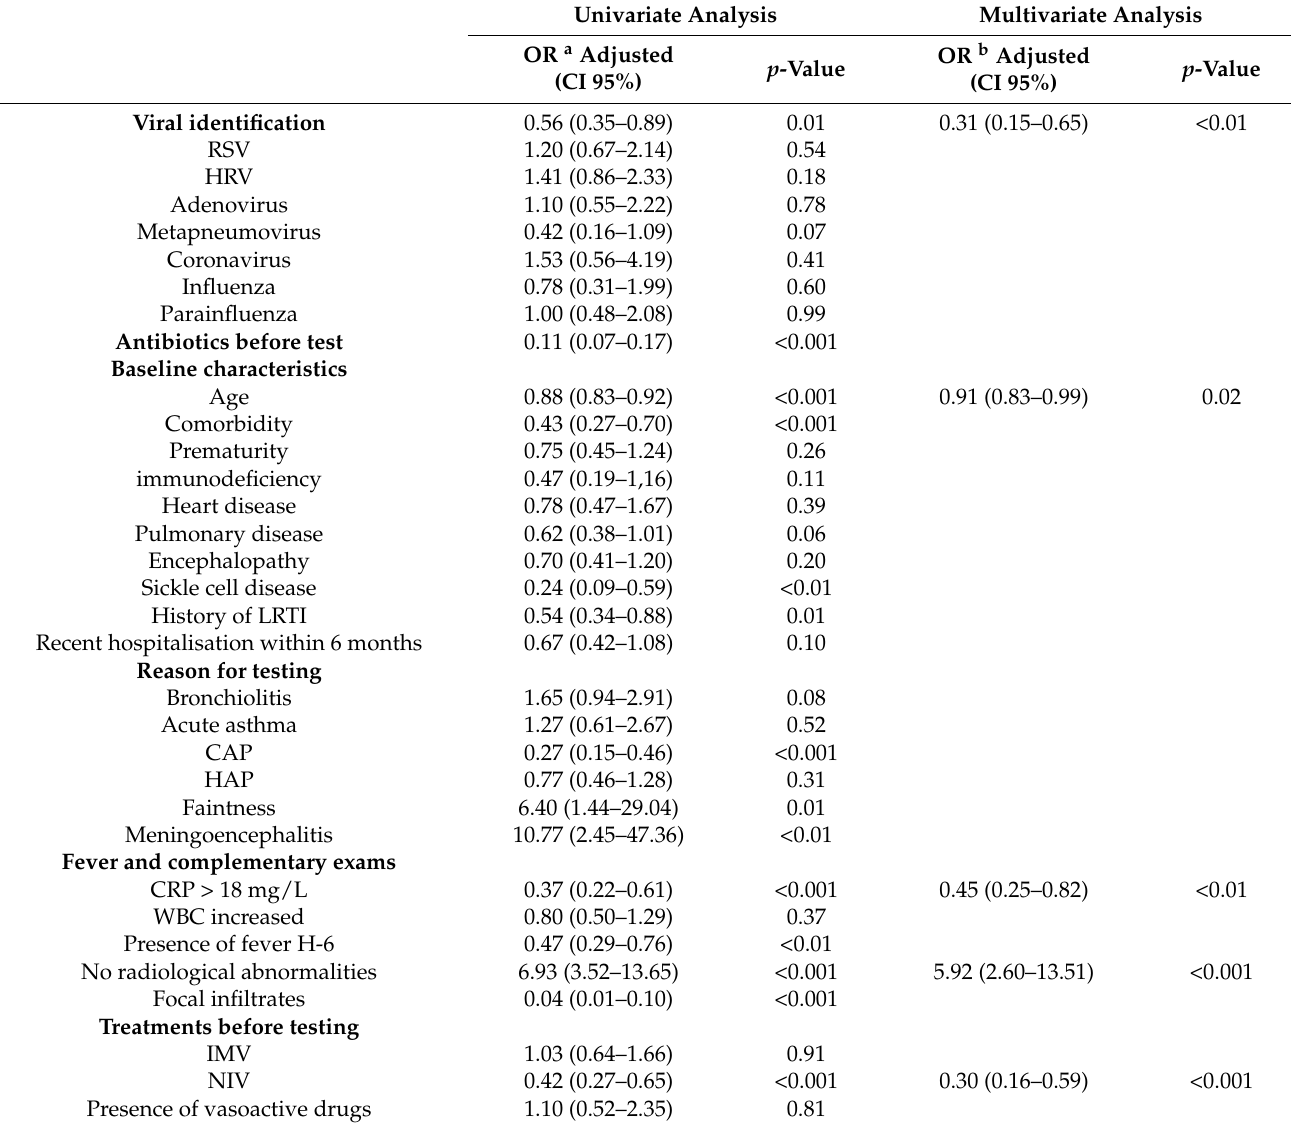
Table 4. Factors associated with the absence of antibiotics after FilmArray ® Respiratory Panel test result (antibiotics stopped or no antibiotics